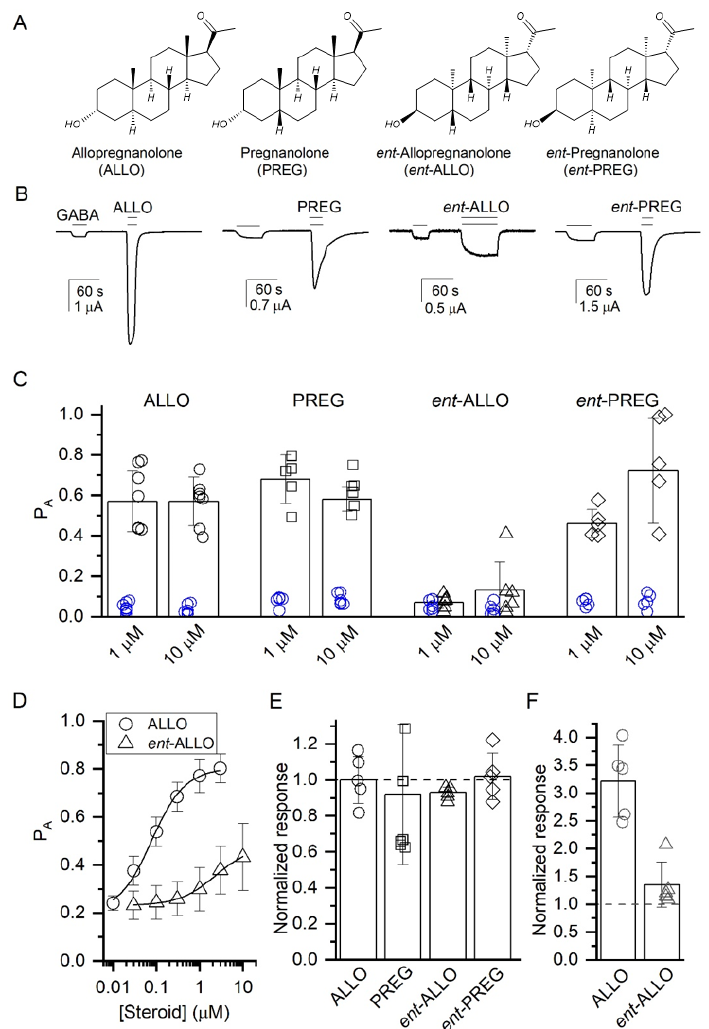
Figure 1. Effects of ALLO, PREG, ent -ALLO and ent -PREG on GABA-elicited currents in α 1 β 3 GABA A receptors expressed in Xenopus oocytes. ( A ) Steroid structures ( B ) Representative traces of currents elicited by low GABA (0.2–0.5 µ M; P A = 0.06 ± 0.03) in the presence or absence of 10 µ M concentrations of steroids. ( C ) Enhancement of currents elicited with low GABA (n = 5) by 1 and 10 µ M steroids. Blue symbols indicate response with GABA alone and black symbols are for GABA + steroid. Open probabilities for steroid-enhanced currents at 1 and 10 µ M were compared using one way ANOVA. There was a statistically significant difference between groups as determined by one-way ANOVA ( F (3,20) = 33.29, p < 0.001 for 1 µ M; F(3,20) = 18.45, p < 0.001 for 10 µ M). A Bonferroni post-hoc multiple comparison test of the means revealed that at both 1 and 10 µ M the effect of ent-ALLO was significantly different compared to the effects of ALLO, PREG, and ent -PREG ( p < 0.001 for each comparison). ( D ) Concentration-response curves comparing potentiation of GABA-elicited currents (GABA = 0.8–3 µ M; target Pa = 0.2) by ALLO and ent -ALLO. Fitting to an MWC model (Equation (1)) indicates that ent -ALLO is both less potent than ALLO (K R,steroid values of 0.22 ± 0.19 and 2.39 ± 1.17 µ M, respectively) and less efficacious (c values of 0.199 ± 0.053 and 0.561 ± 0.065, respectively). ( E ) Potentiation of GABA (target P A = 0.06) by ALLO, ent -ALLO, PREG and ent -PREG in α 1 (Q242L) β 3 receptors. The data indicate that potentiation of GABA responses by all of the steroids is eliminated by a mutation in the intersubunit site. ( F ) Potentiation of GABA (P A < 0.1) by ALLO and ent -ALLO (10 µ M) in α 1 (V227W) β 3 receptors. The difference in efficacy between ALLO and ent-ALLO is preserved in the V227 W mutant. Figures ( E , F ) show the ratio of the response to GABA + steroid to GABA alone, with a ratio of 1 indicating no steroid